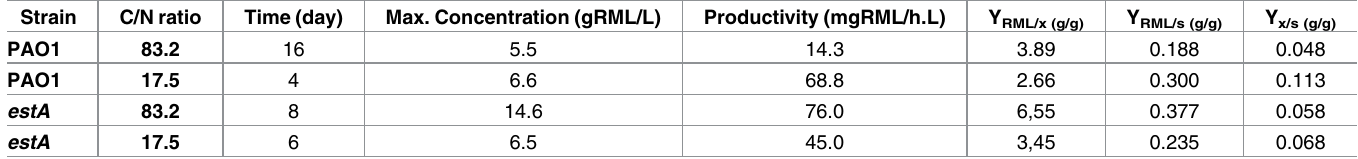
Table 3. Comparative biotechnological bioprocess parameters for four fermentations, using P . aeruginosa PAO1 and P . aeruginosa-estA and two different C/N ratios for the MSP medium (83.2 and 17.5 mol/mol). All data calculatedfor the day when productionreachedits maximum RML